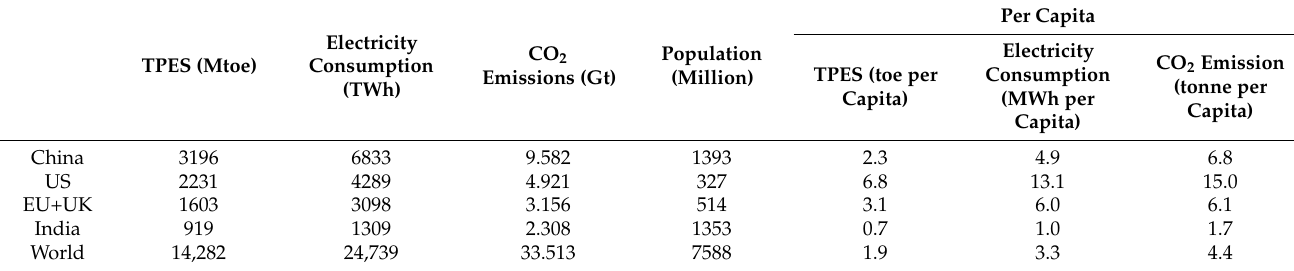
Table 1. Annual Total Primary Energy Supply (TPES), electricity consumption, carbon dioxide emissions from energy use, and population by country or region. Additionally shown are per capita rates of TPES, electricity consumption and CO 2 emissions from energy use. Data from